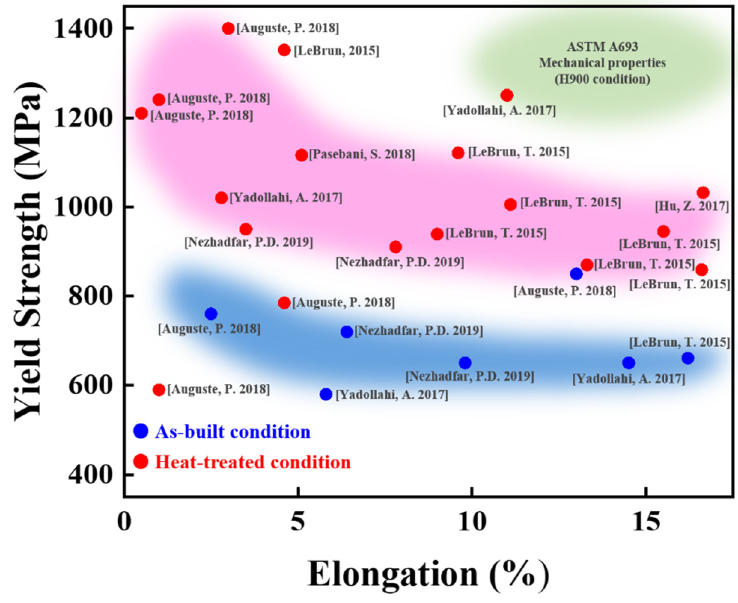
Figure 1. Mechanical properties of 17-4 PH SS produced by L-PBF from previous studies [23,26–31].